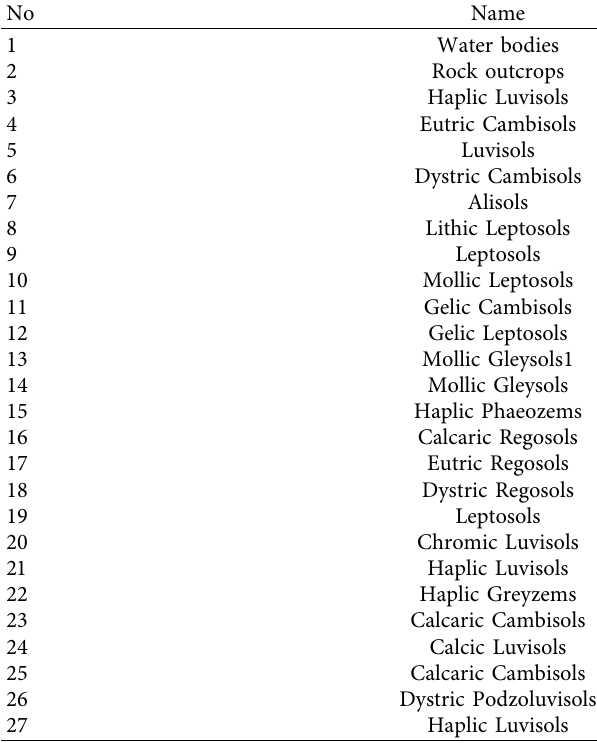
Table 1: Soil types of the Minjiang